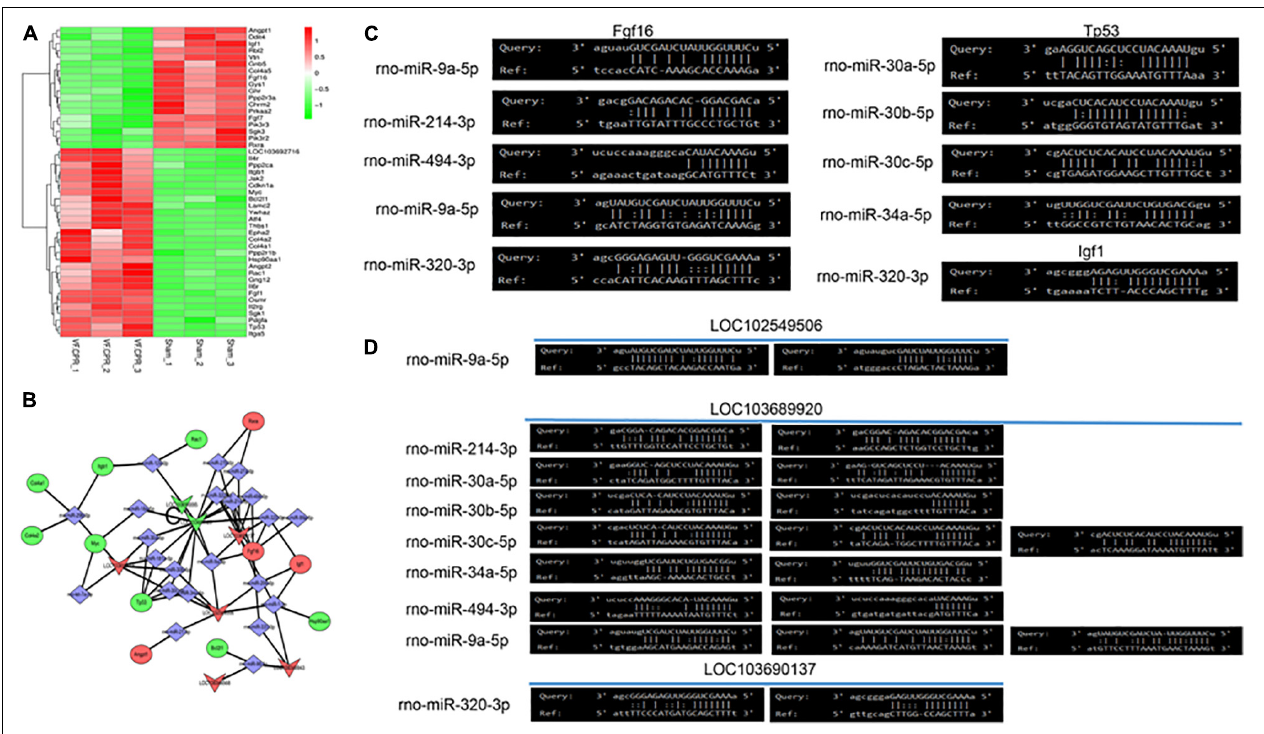
FIGURE 4 | Bioinformatics analysis of the key lncRNAs involved in the PI3K/Akt signaling pathway. (A) Differentially expressed mRNAs in the PI3K/Akt signaling pathway post the CA-CPR treatment; (B) Analysis of the ceRNA effects of the lncRNAs that were involved in the PI3K/Akt signaling pathway; (C) Bioinformatics analysis of the miRNAs-mRNAs mutual interaction; (D) Bioinformatics analysis of the lncRNAs-miRNAs mutual